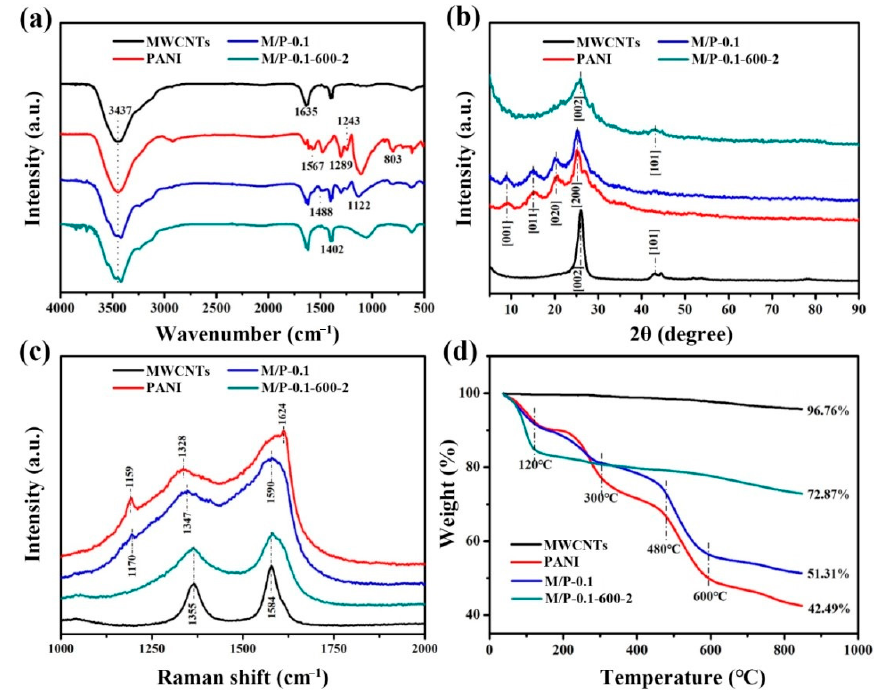
Figure 1. Characteristics of M/P-0.1-600-2, M/P-0.1, PANI, and MWCNT samples: ( a ) FTIR spectra, ( b ) XRD patterns, ( c ) Raman spectra, and ( d ) TGA